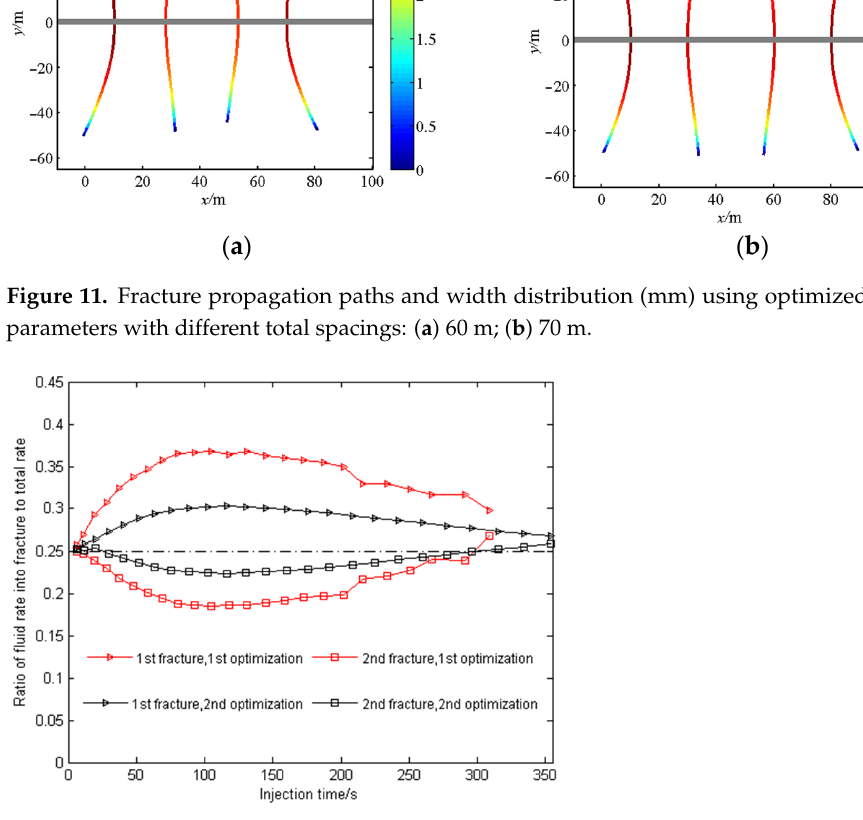
Figure 12. Comparison of ratio of fluid rate into each fracture using first round optimization of cluster spacings and second round optimization of perforation parameters.